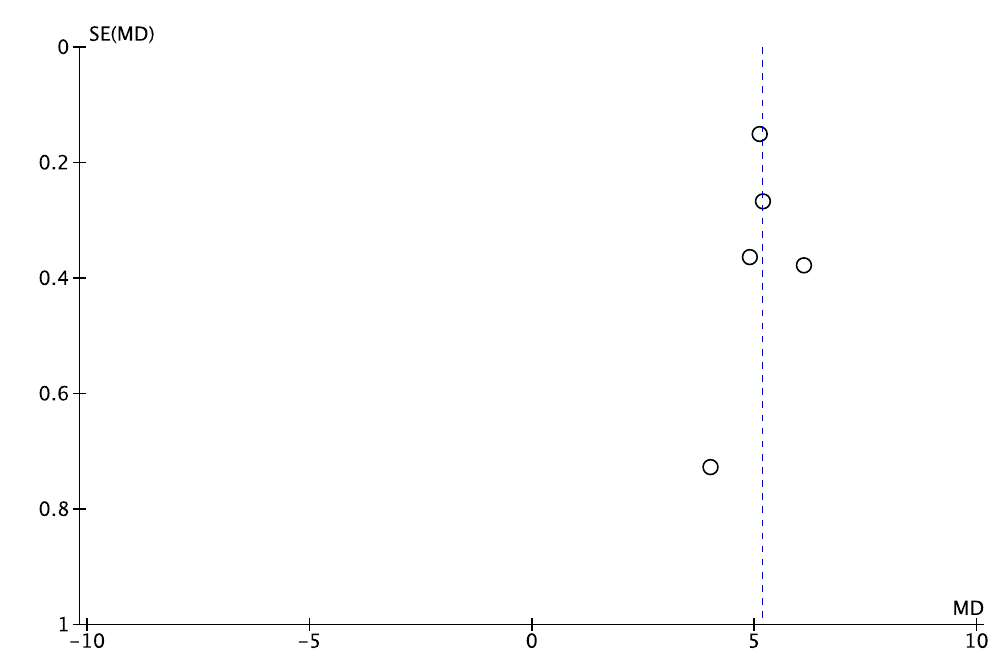
Figure 7. Funnel plot of comparison: VAS, outcome in BT. SE: Standard Error; MD: Mean Difference.